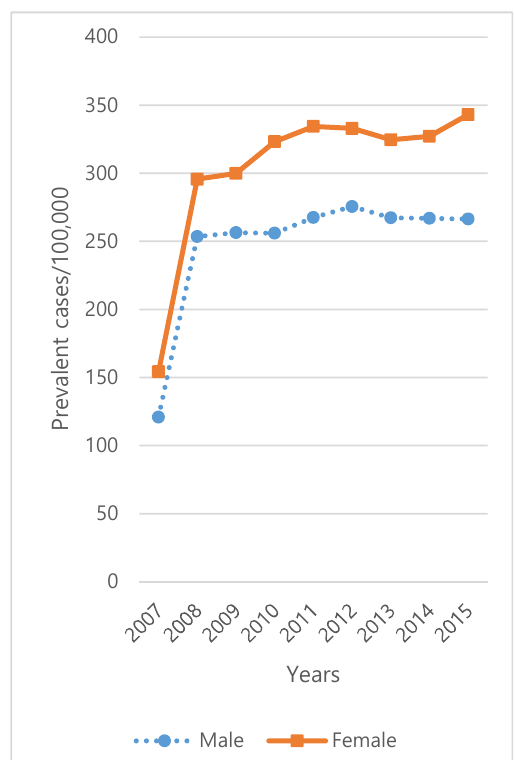
( B ) Prevalence of bronchiectasis according to age